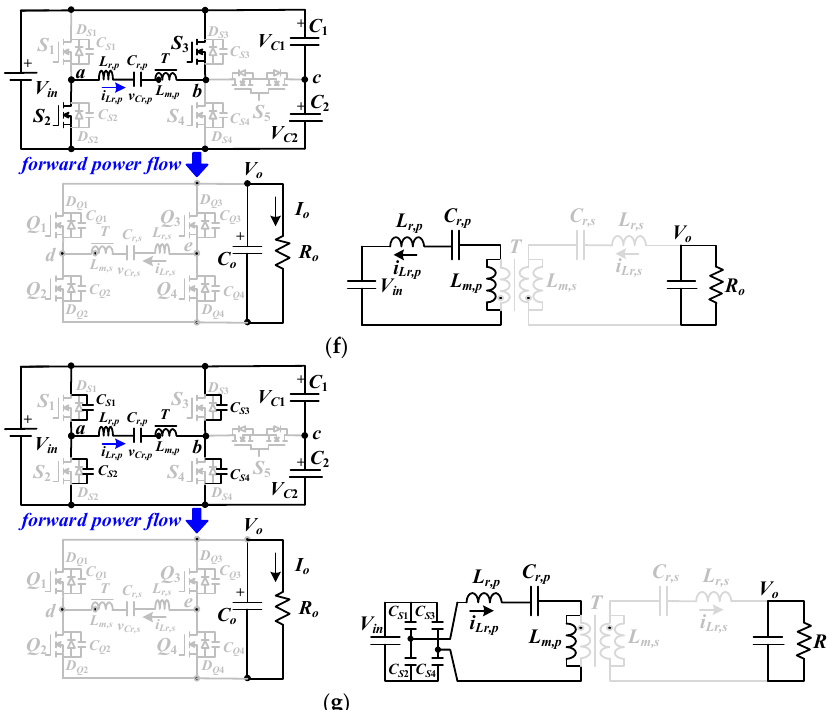
Figure 6. The corresponding mode circuits under forward power operation and low input voltage range: ( a ) PWM signals, ( b ) mode 1, ( c ) mode 2, ( d ) mode 3, ( e ) mode 4, ( f ) mode 5, ( g ) mode 6.